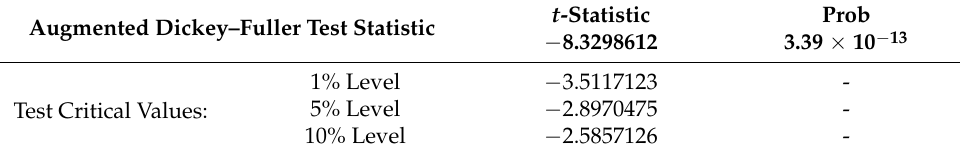
Table 2. ADF test results of offset distance.